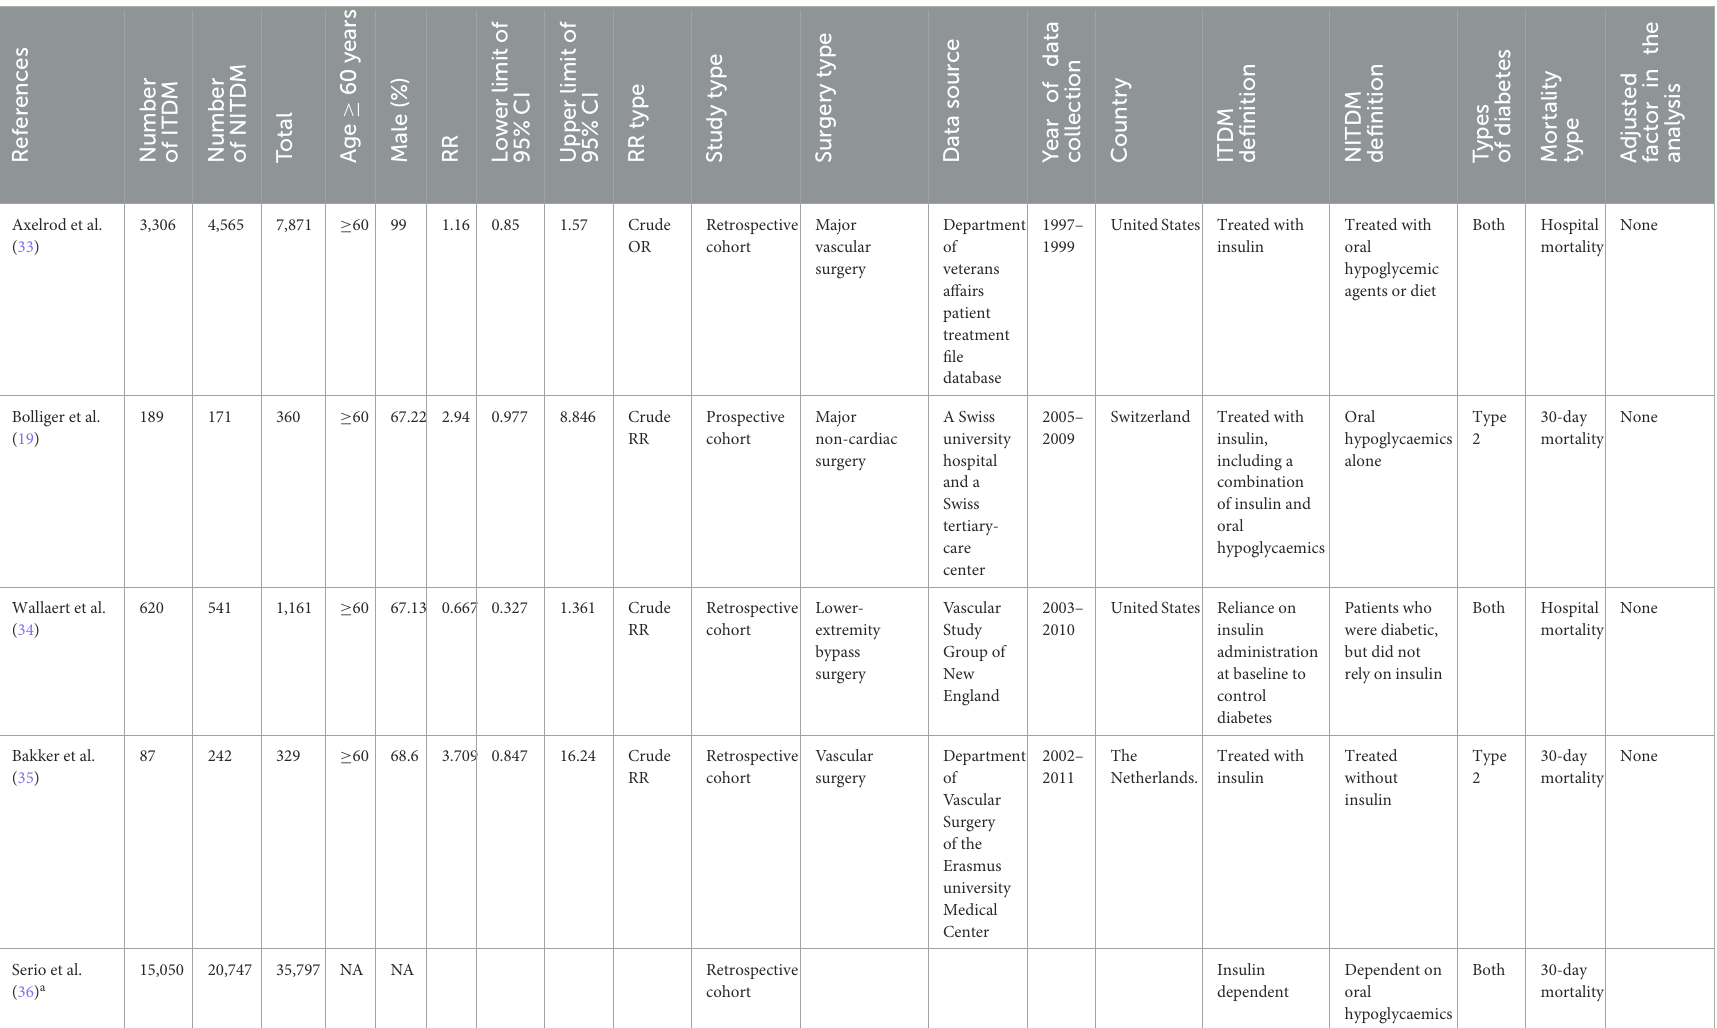
TABLE 1 Characteristics of the included